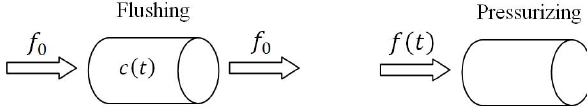
Fig. 4. The schematic of the flask sampling for a single flask, which consists of two processes: flushing, air flowing into the flask is in- stantaneously mixed and then flows out of the flask at the same flow rate; pressurizing, air flows into the flask with decreasing flow rate until the flask sampling is completed.